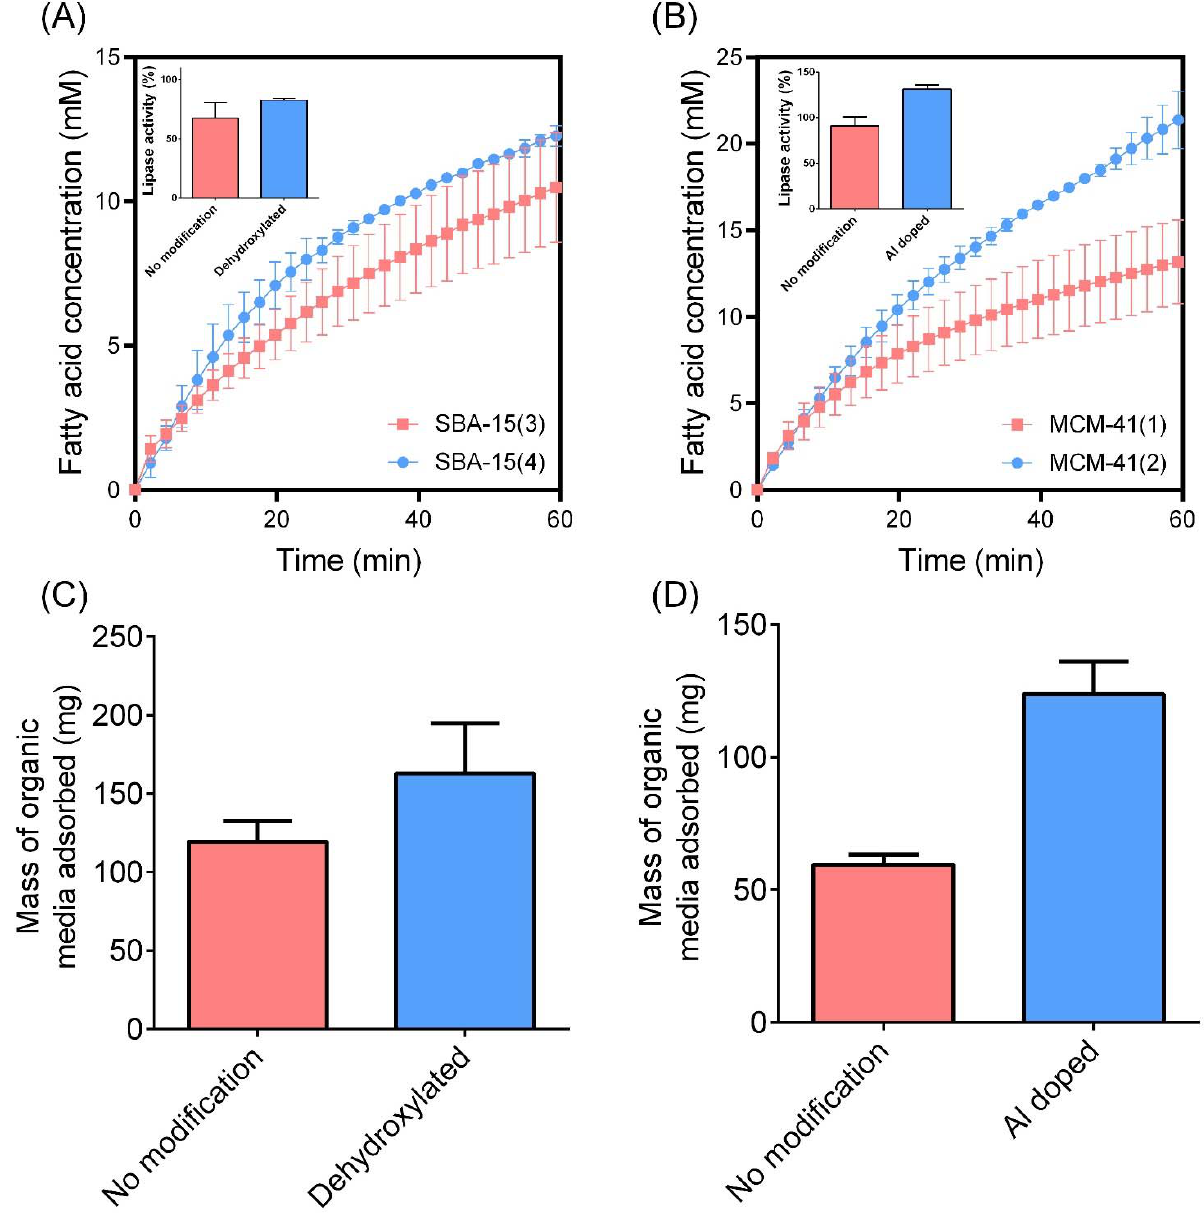
Figure 7. In vitro lipid digestion profiles highlighting the impact of surface chemistry on lipolysis kinetics for ( A ) SBA ‐ 15 and ( B ) MCM ‐ 41 mesoporous silica. Insets: lipase activity as a function of surface chemistry. The extent of organic media adsorption at the completion of in vitro digestion studies for ( C ) SBA ‐ 15 and ( D ) MCM ‐ 41 samples, quantified using TGA. In vitro digestion studies were performed under simulated fed state conditions, with data representing the digestion occuring during the intestinal phase (pH 6.0). Data represent mean ± S.D. ( n = 3).